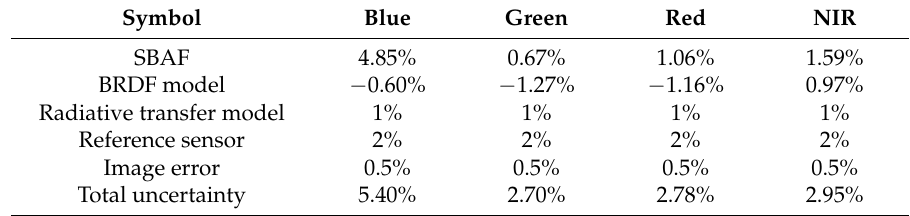
Table 9. Total calibration uncertainty of cross-calibration using MODSI over Golmud test site. Symbol Blue